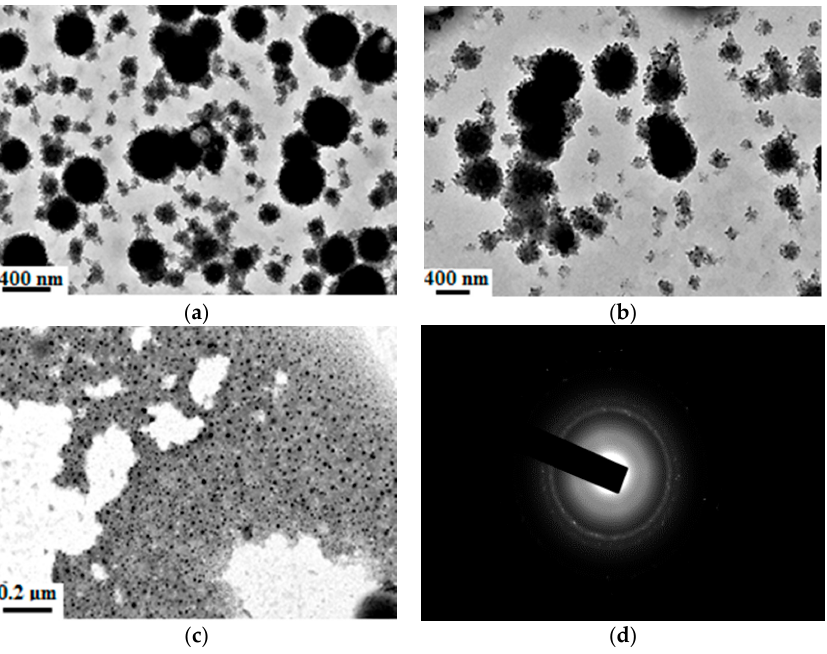
Figure 4. TEM spectra of organic-inorganic super hydrophobic nanocomposite emulsion. ( a ) Strawberry particle; ( b ) small particles adsorbed on the big particles; ( c ) film; and ( d ) diffraction pattern.